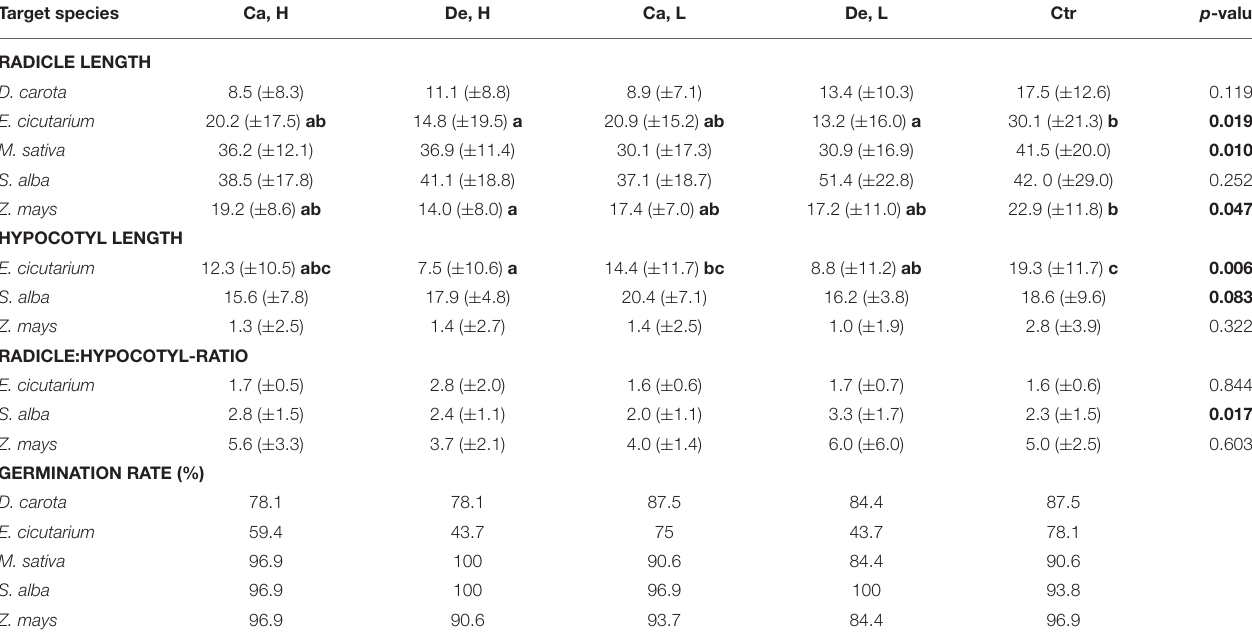
TABLE 3 | Results of allelopathy experiment, testing the effect of Erodium cicutarium aqueous leaf extracts on radicle and hypocotyl length and germination rate of five target species. Target species Ca, H De, H Ca, L De, L Ctr p